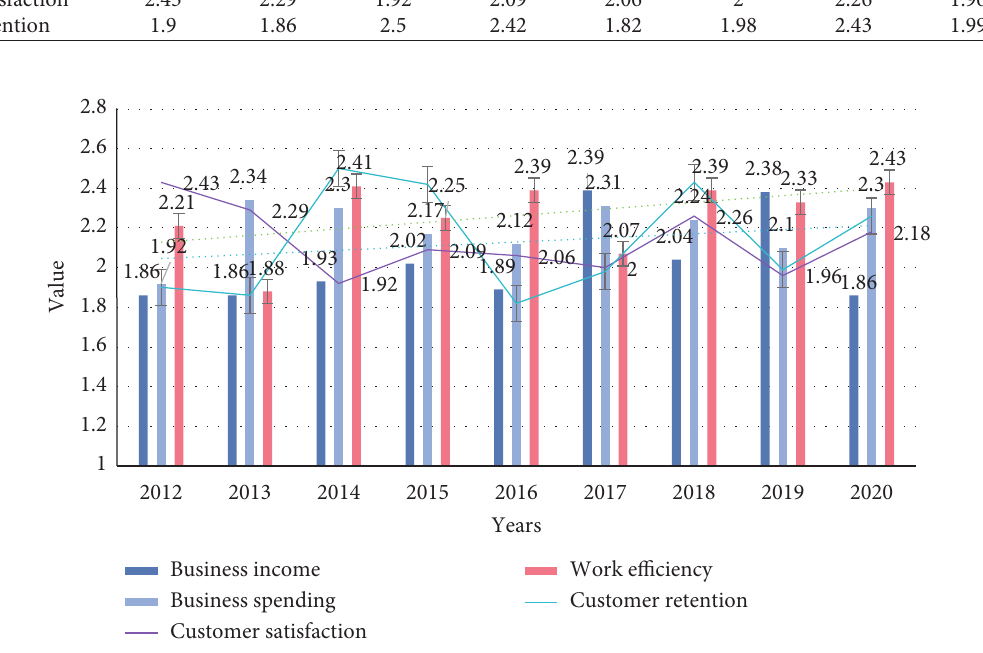
Figure 1: Enterprise status. Table 2: Enterprise customer classification.